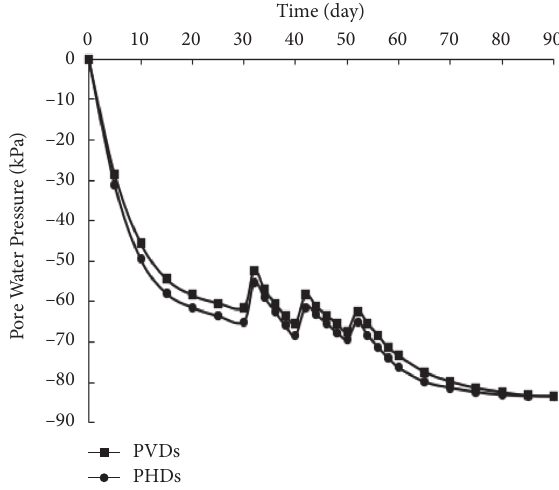
Figure 12: Relationship curve between pore water pressure and